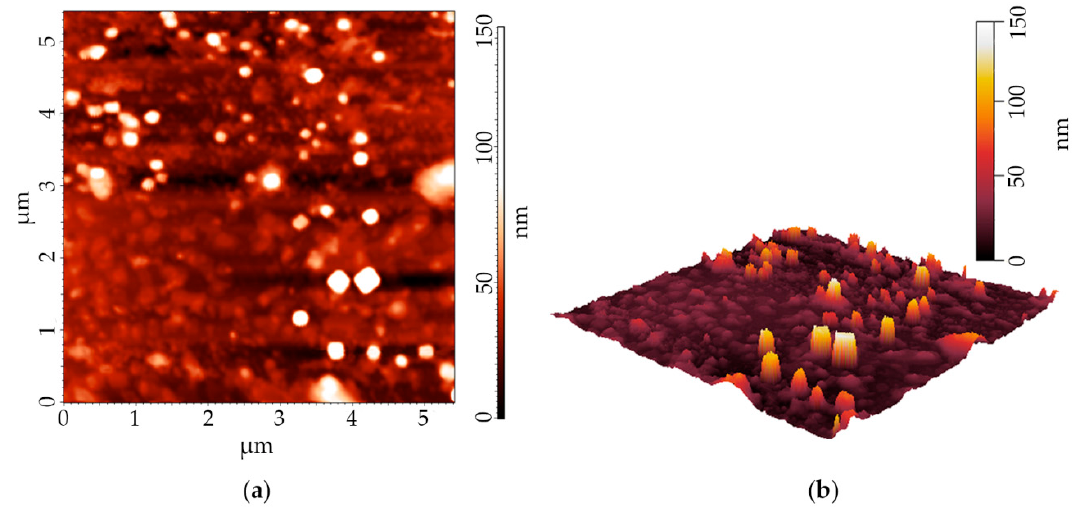
Figure 1. ( a ) Typical height image of DCL by means of atomic force microscopy. ( b ) Three-dimensional (3D) reconstruction of DCL height image. The presented image corresponds to the MDCL1.